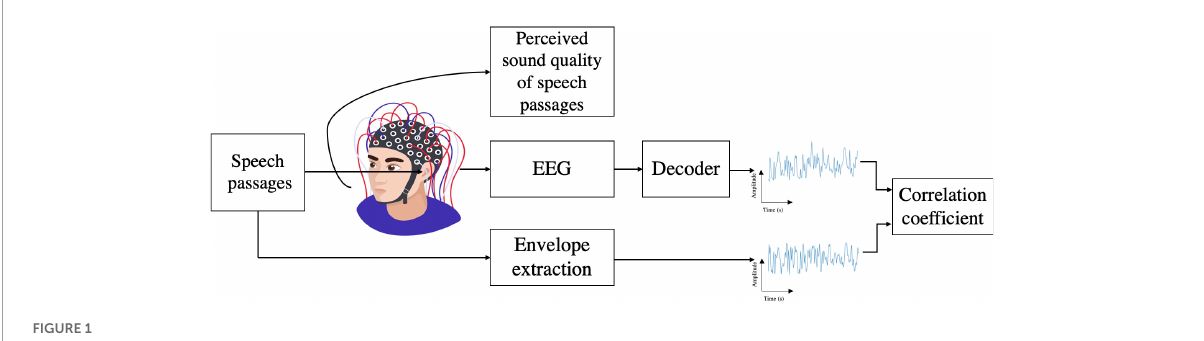
FIGURE1 Behavioral and EEG experiment